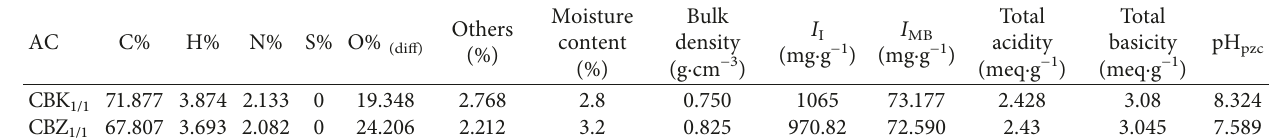
Table 1: Elemental analysis, total acidity and basicity, and physical and chemical properties.